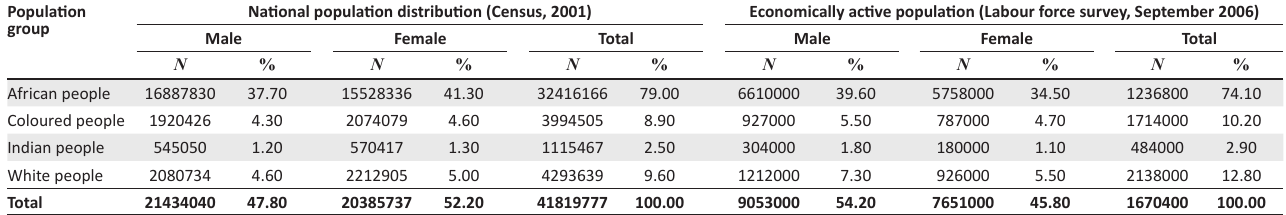
TABLE 1: Profile of the national population by race and gender and profile of the economically active population by race and gender. Population